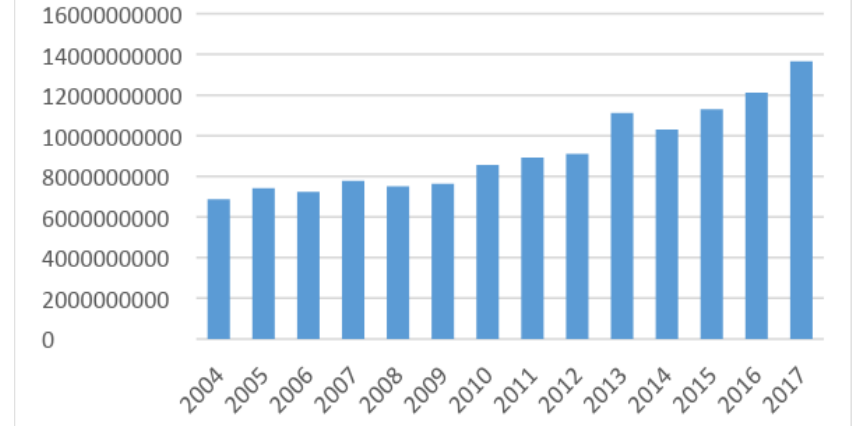
Figure 1: Statistic of broiler chicken production in Malaysia (2004-2017) (Department Veterinary Services, 2017)